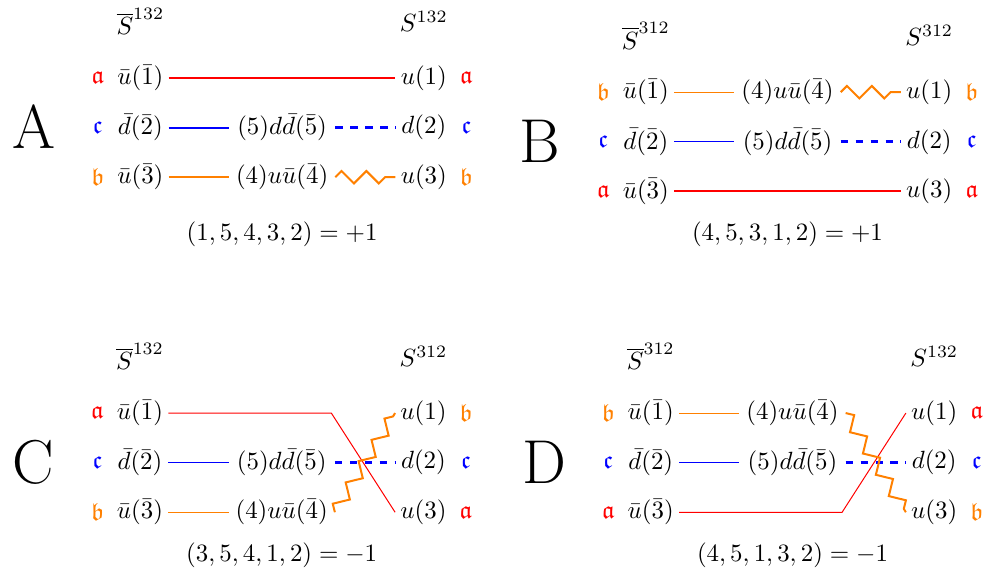
( y ) O dd (0) ( C ). Depending on Figure 31 . Contributions of C 1 type for the combination O uu 1 ,uudd i j the evaluation method, we use different symbols to depict the propagators: the forward propagator M z is represented by a simple line, the stochastic propagator ψ by a zigzag line, and the sequential propagator X (without the incorporated forward propagator and the stochastic source) by a dashed line. The colors indicate the quark lines: red corresponds to a , orange to b , and blue to c . The combination of the quark lines with the numbers (1) , (2) , (3) at the sink or (¯1) , (¯2) , (¯3) at the source determines the sequential source type S (see (A.18)) or the contraction S n ( a ) n ( b ) n ( c ) n ( a ) n ( b ) n ( c ) (see (A.19)), respectively. The resulting permutation is also given for each contraction. Moreover, at the bottom line of each panel we give the permutation of quark fields represented by the propagator and the corresponding sign, which enters the total contribution and hence the physical matrix